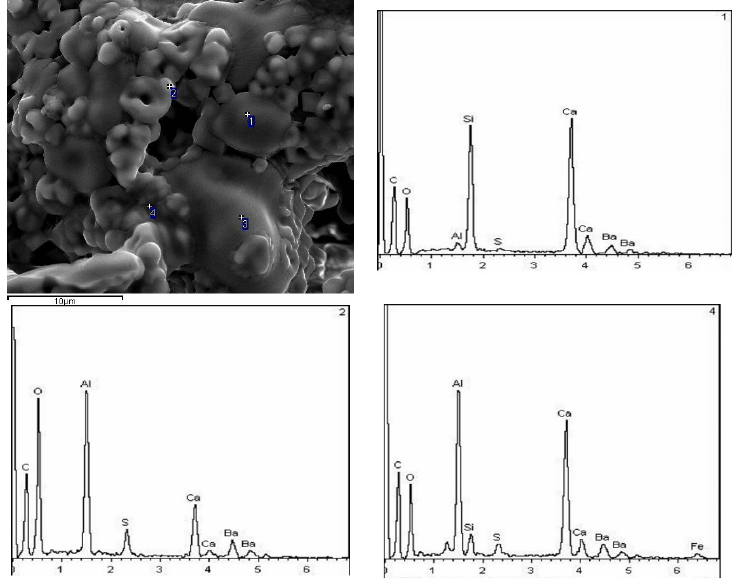
Figure 13. SEM-EDS photographs of the F3 clinker at 1300 °C .